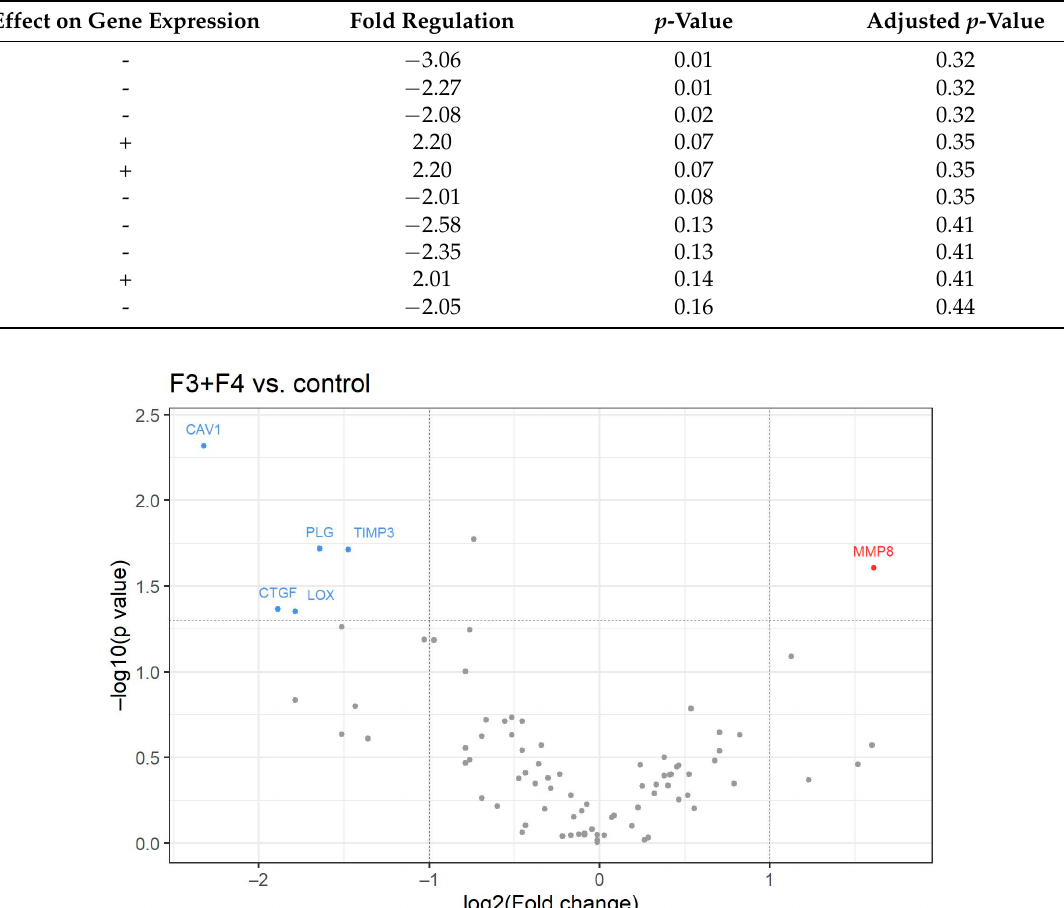
Table 3. Gene expression patterns in patients with chronic hepatitis C with mild fibrosis (F1/2) and controls. p -values were corrected for multiple testing with Benjamini–Hochberg method.